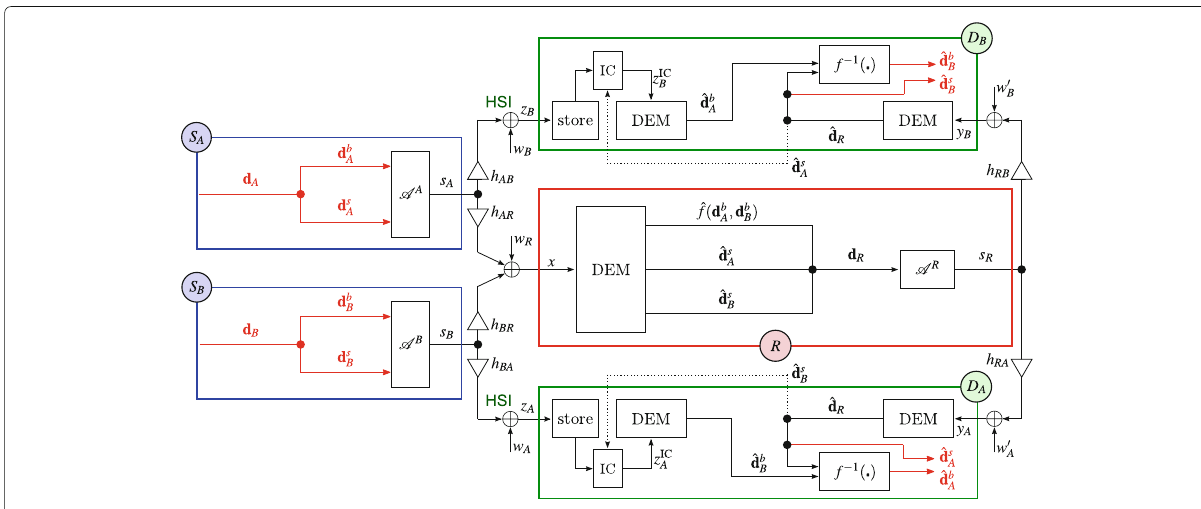
Fig. 2 Relaying scheme for the uncoded WBN system. DEM stands for a hard decision demodulator, IC is the interference